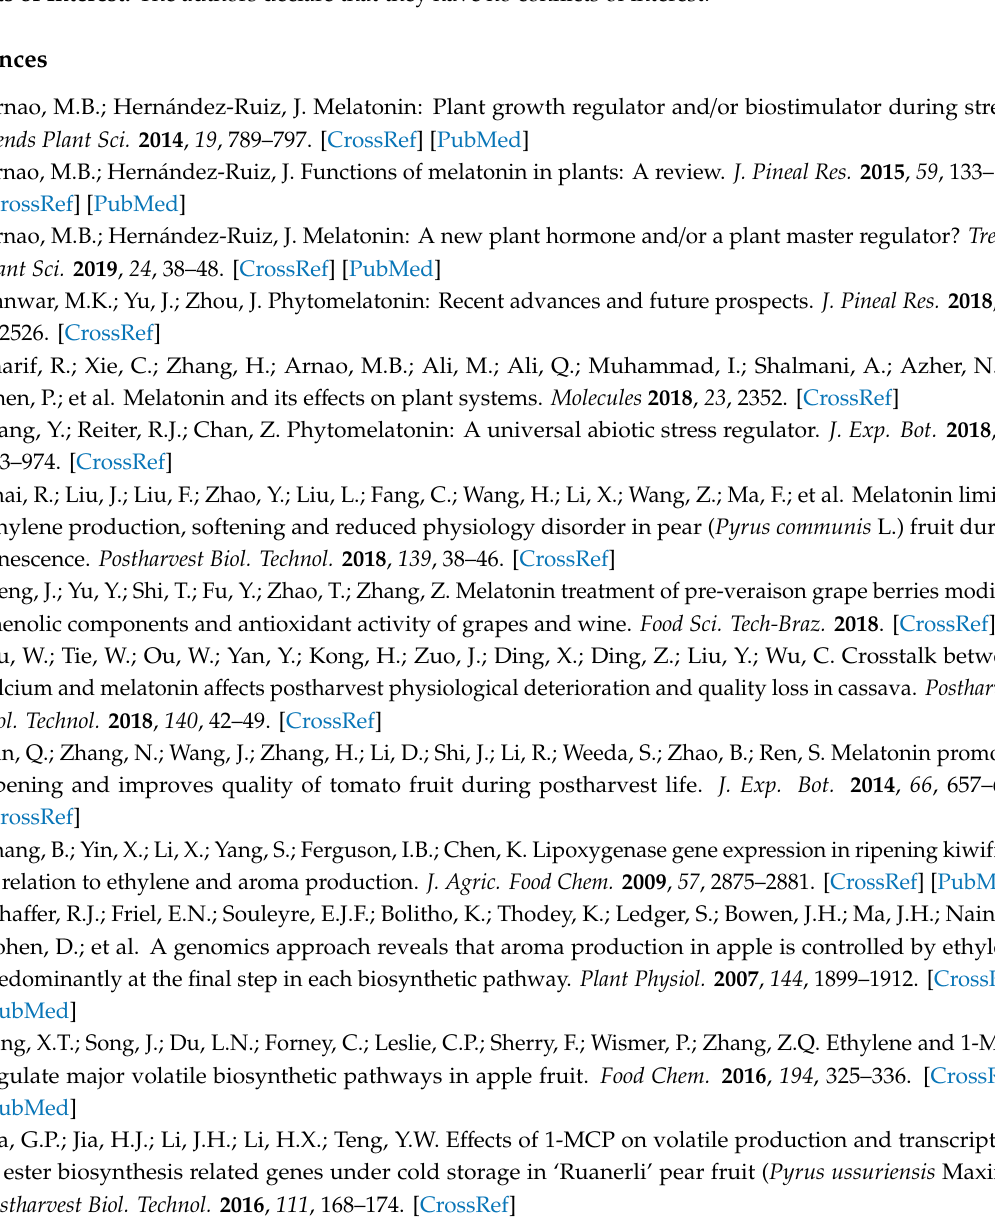
Supplementary Materials: Figure S1: GC-MS chromatograms of volatile production determinations, Table S1: Authentic standard compounds used in the GC-MS analysis and standard curve equations, Table S2: List of qRT-PCR